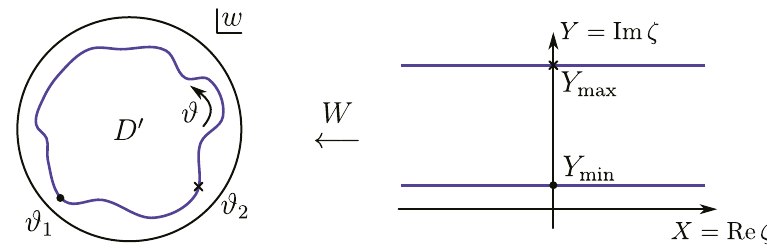
Figure 5 . To evaluate the non-local part of the action, we identify the domain of the Poincare disk with the upper half-plane and approximate D ′ as shown on the